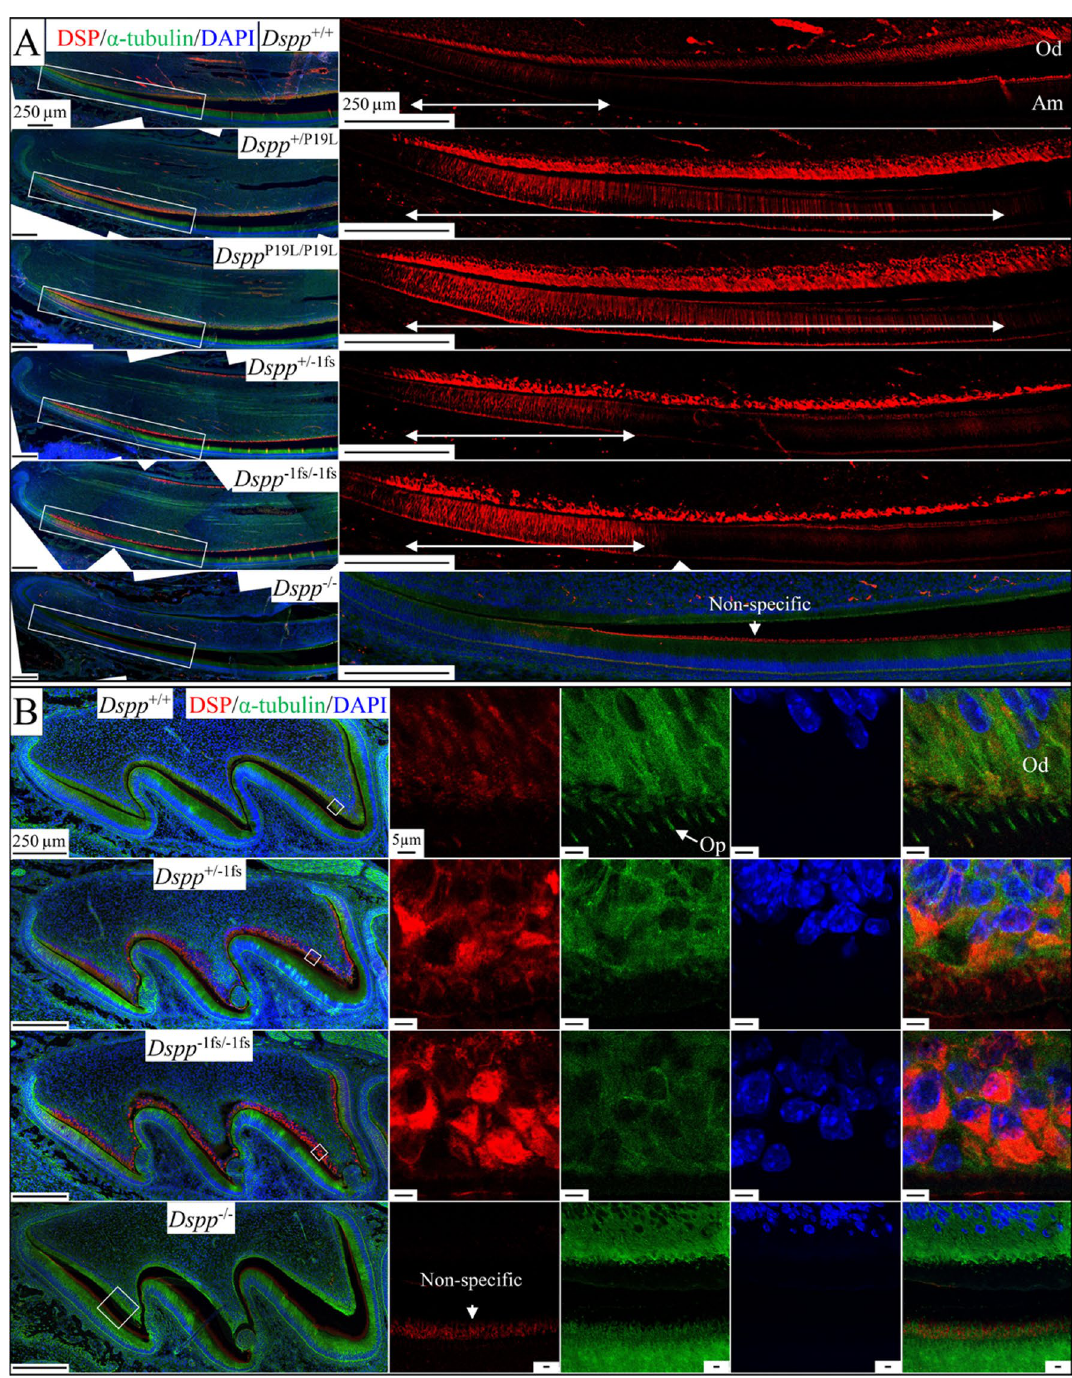
Figure 4. Mutant DSPP accumulation within the odontoblasts and ameloblasts of Dspp P19L and Dspp -1fs mice. Immunohistochemistry on D14 mandibular incisors (A) and D3 maxillary 1st molars (B), showed DSP (red), α-tubulin (green; boundaries of cells), and DAPI (blue; nucleus). The anti-DSP antibody showed some light, non-specific signal associated with the ameloblast Tomes’ processes in the Dspp −/− mice. ( A ) In Dspp +/+ incisors, intracellular DSP signal intensity was low to medium in odontoblasts (Od) and low intensity in ameloblasts (Am). Strong intracellular accumulation of DSPP is observed in odontoblasts and ameloblasts of Dspp P19L and Dspp −1fs mice. White double arrows mark ameloblasts with detectable intracellular DSP signal, indicating Dspp P19L ameloblasts with prolonged retention of DSPP. Scale bar: 250 μm. ( B ) In Dspp −1fs maxillary 1st molars, intracellular DSP signals show that DSPP is seen in odontoblasts and neighboring pulp cells. The DSP-positive cells are not tall columnar in shape, arranged in a sheet, or extending odontoblastic processes (Op) into dentin. Scale bars: 250 μm (left)/5 μm (right). See also Figure